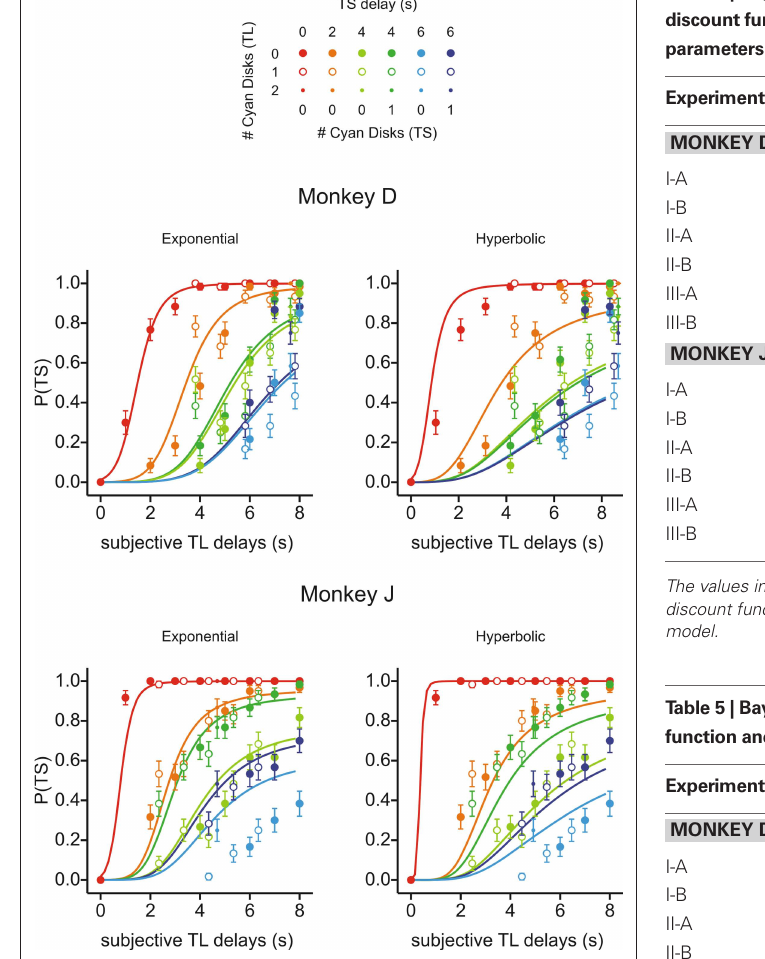
Table 4 | Bayesian information criterion (BIC) for the general hyperbolic discount function and their parameters ( k parameters for the q-exponential discount function ( k